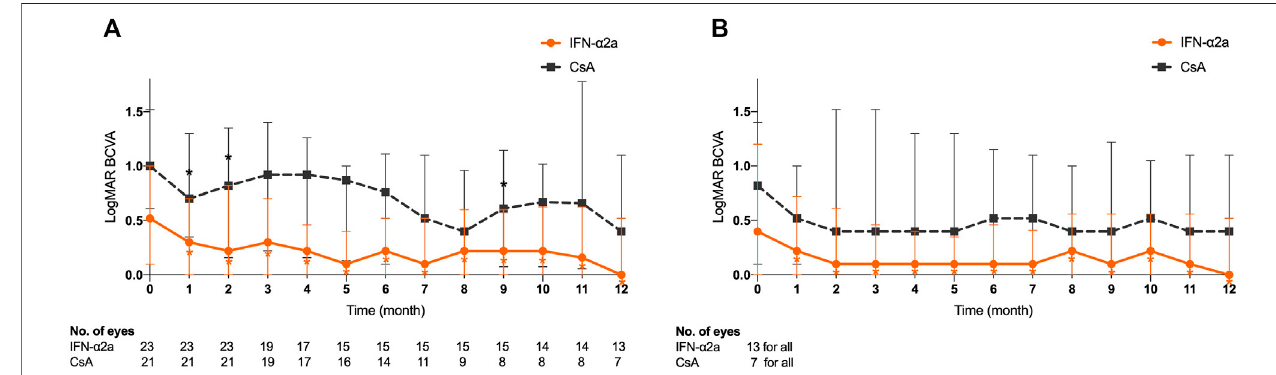
FIGURE 2 | Changes in logarithm of the minimum angle of resolution (LogMAR) best-corrected visual acuity (BCVA) for eyes treated with interferon alpha-2a (IFN- α 2a) and cyclosporine-A (CsA). (A) Changes in median LogMAR BCVA for all eyes treated with IFN- α 2a (n (cid:1) 23) and CsA (n (cid:1) 21) during the 12-month follow-up. (B) ChangesinLogMARBCVAforeyeswithcompleteremissiontreatedwithIFN- α 2a(n (cid:1) 13)andCsA(n (cid:1) 7)duringthe12-monthfollow-up.Dataareshownasthemedian and IQR. *: p <